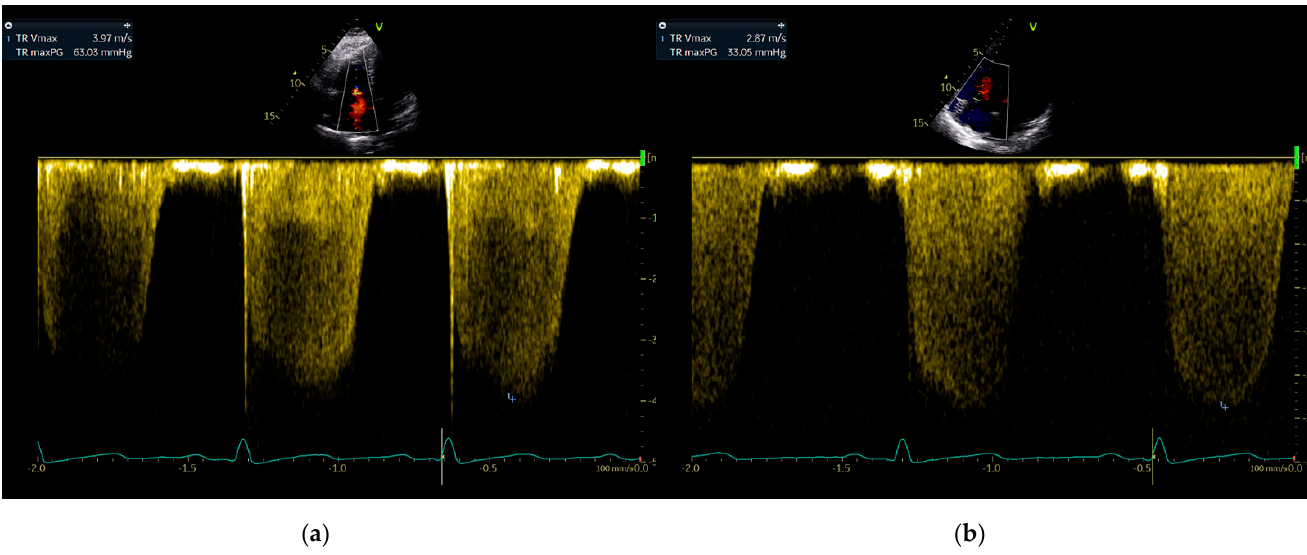
Figure 1. Echocardiogram in a patient with a high-altitude dweller, showing an exaggerated rise in pulmonary artery pressure during the cold season. Peak tricuspid regurgitation jet velocity estimating right ventricular systolic pressure measured in ( a ) the first examination in late winter, and ( b ) a repeat examination in late summer.